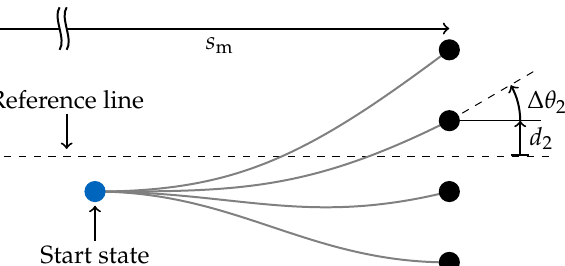
Figure 5. Example initial edges (gray lines) connecting the start state (blue dot) with the initial layer and fulfilling the individual end pose of each spatial node (black dots). Coordinates are shown exemplarily for the second